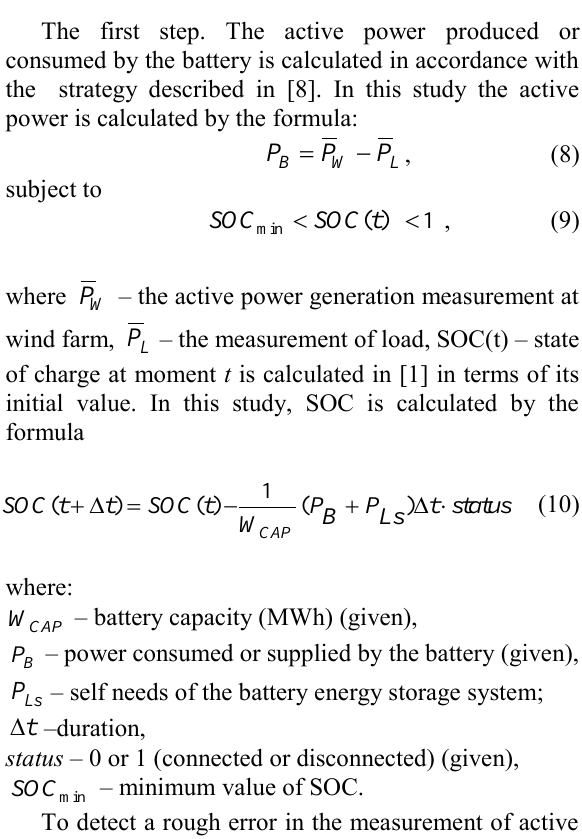
Fig.1 . Bad data detection